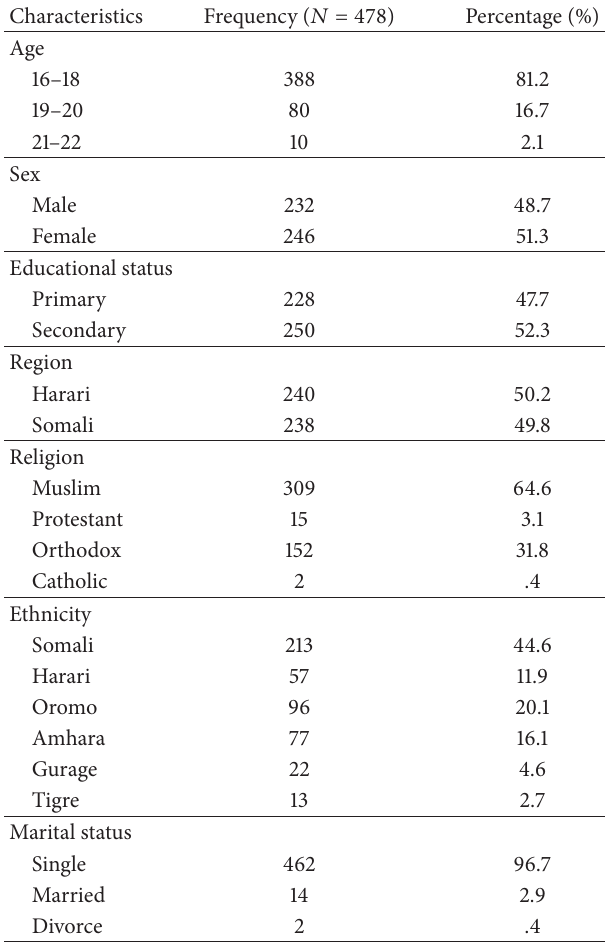
Table 1: Sociodemographic characteristics of the study population in Somali and Harari regions, Eastern